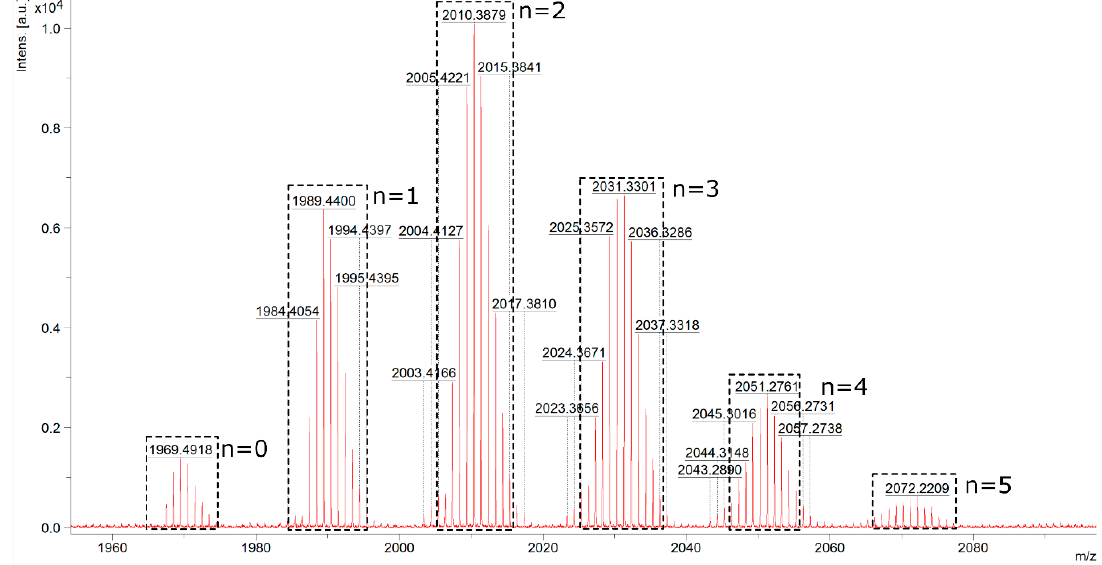
Figure 3. MALDI-TOF of the reaction mixture (Me–C 6 H 4 –CH=CH–SiMe 2 –) 8 − n (Cl–C 6 H 5 –CH=CH– SiMe 2 –) n Si 8 O 12 (where n = 0–5) of the designated 7b 5 c 3 .